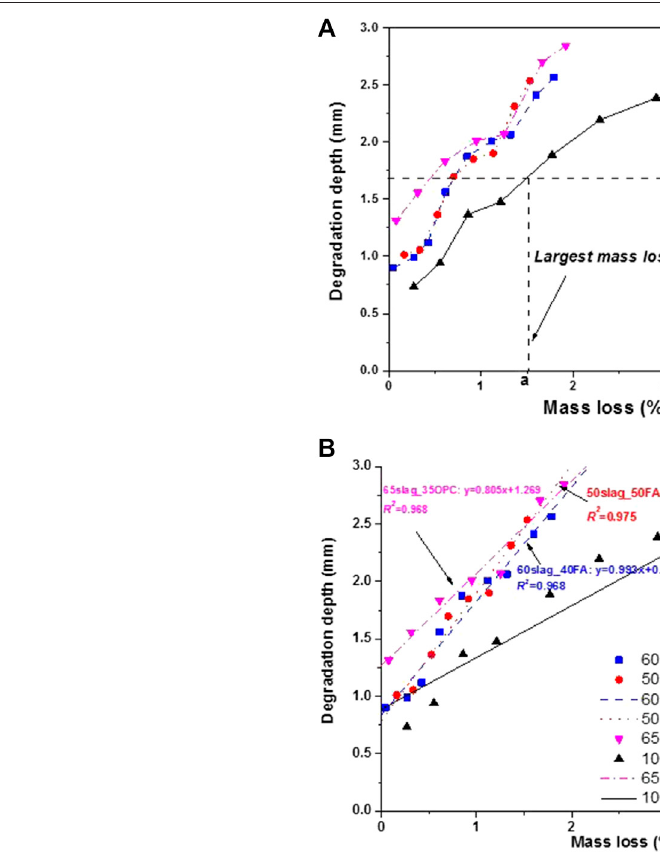
Frontiers in Materials |